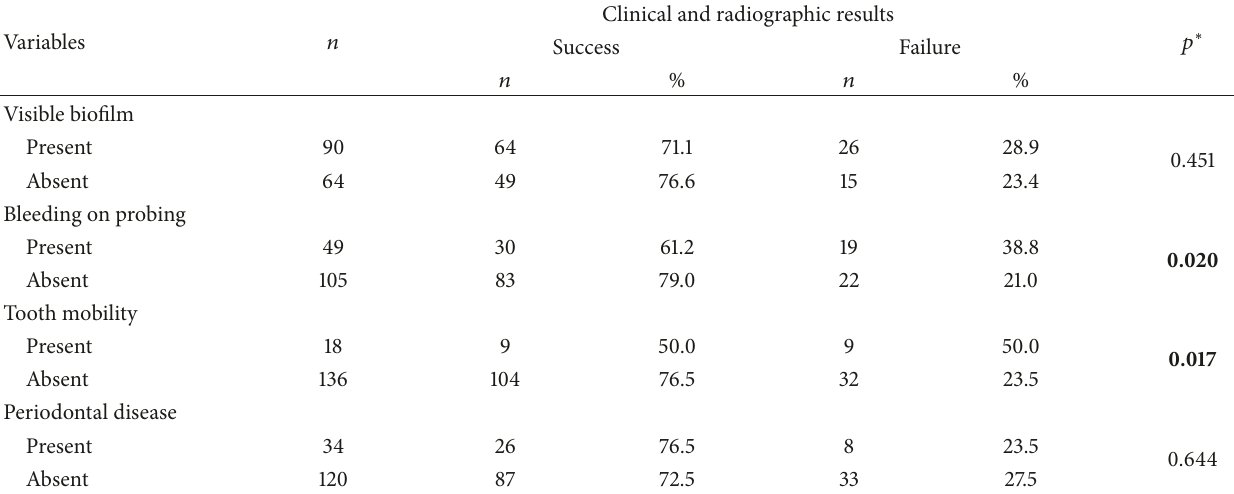
Table 5: Clinical and radiographic success according to periodontal parameters.